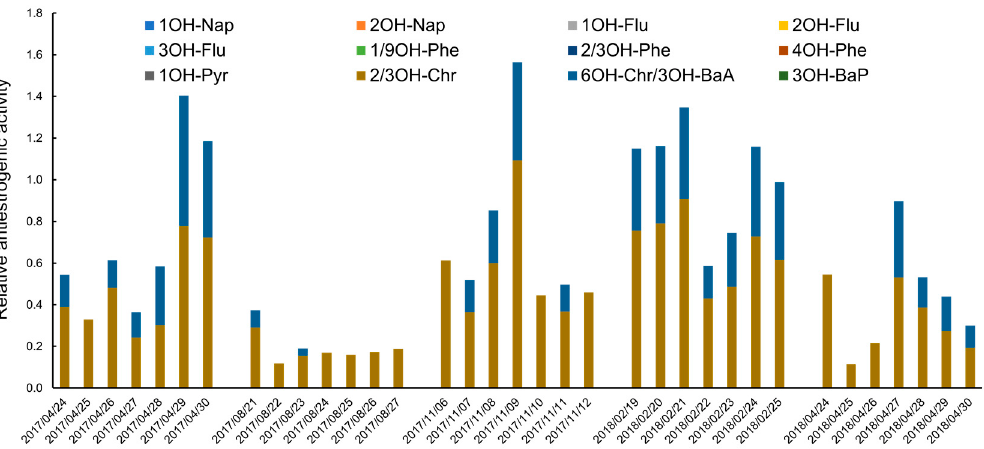
Figure 6. Daily relative antiestrogenic activities of atmospheric OH-PAHs in April, August, and November 2017, and February and April 2018 in Kanazawa. November 2017, and February and April 2018 in